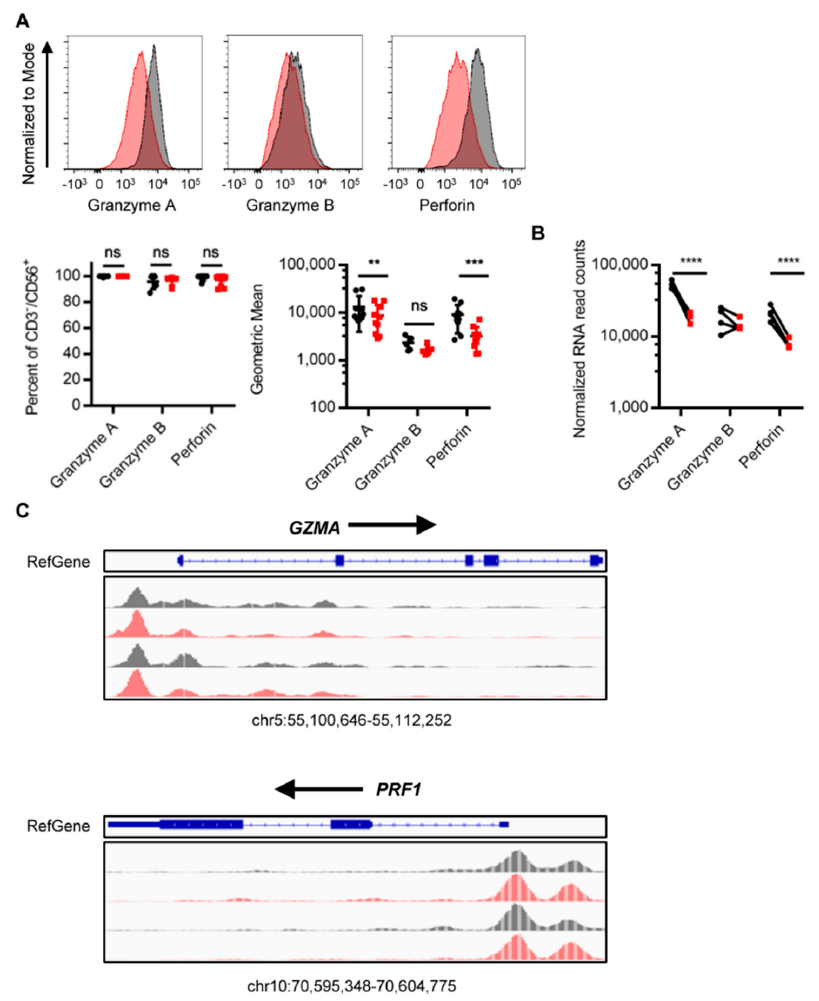
Figure 5. TGF β i decreases granzyme A and perforin expression. ( A ) Granzyme and perforin protein expression in TGF β i NK cells were measured by flow cytometry. Percent positive NK cells and relative expression (gMFI) were depicted. Granzyme A and perforin ( n = 10), granzyme B ( n = 5). A representative flow plot is depicted. ( B ) mRNA ( n = 4 for RNA) of granzymes and perforin was measured using RNA-seq. ( n = 4 for RNA). ( C ) Chromatin accessibility of GZMA and PRF1 loci as measured by ATAC-seq. Control in black, TGF β i in red. Data are Mean ± SD. Statistical differences were determined by paired t -test and RNA-seq by DESeq2. * p ≤ 0.05, ** p ≤ 0.01, *** p ≤ 0.001, **** p ≤ 0.0001. See also Figure